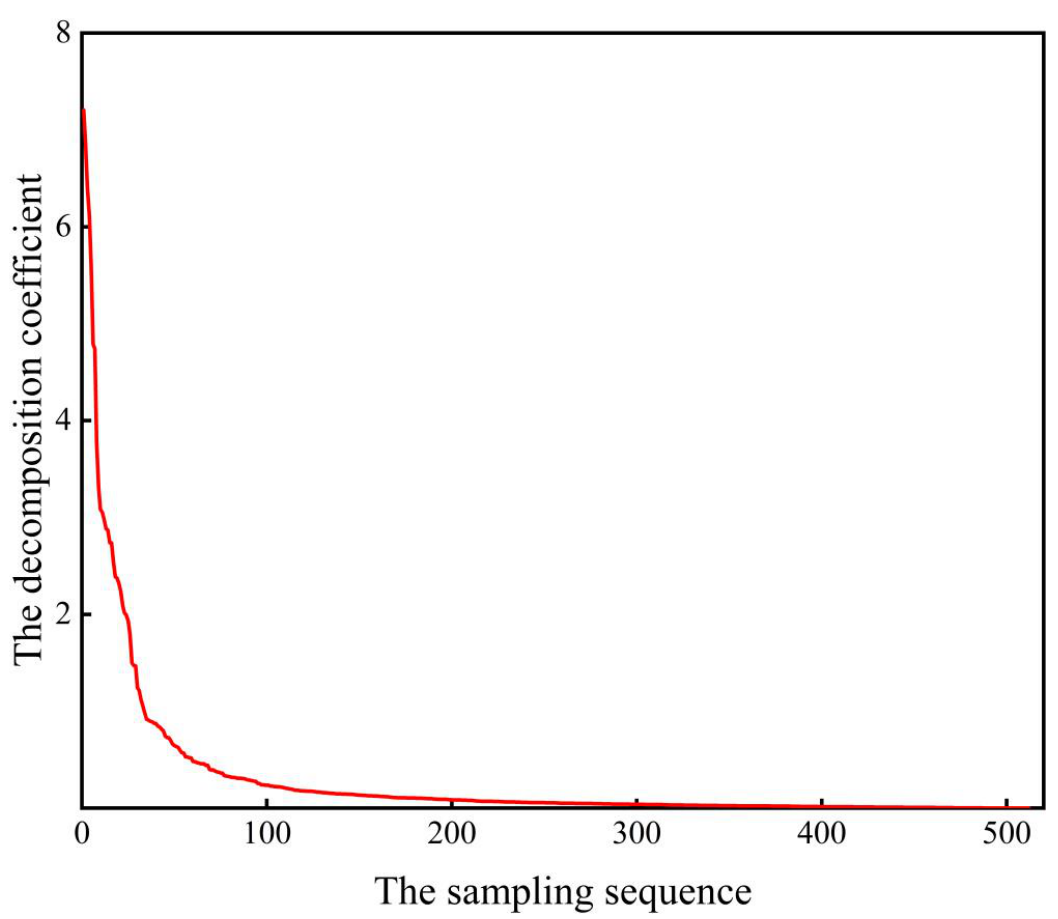
Figure 3. The decay distribution of the transformation coefficient of the mechanical vibration signal under the DCT base.